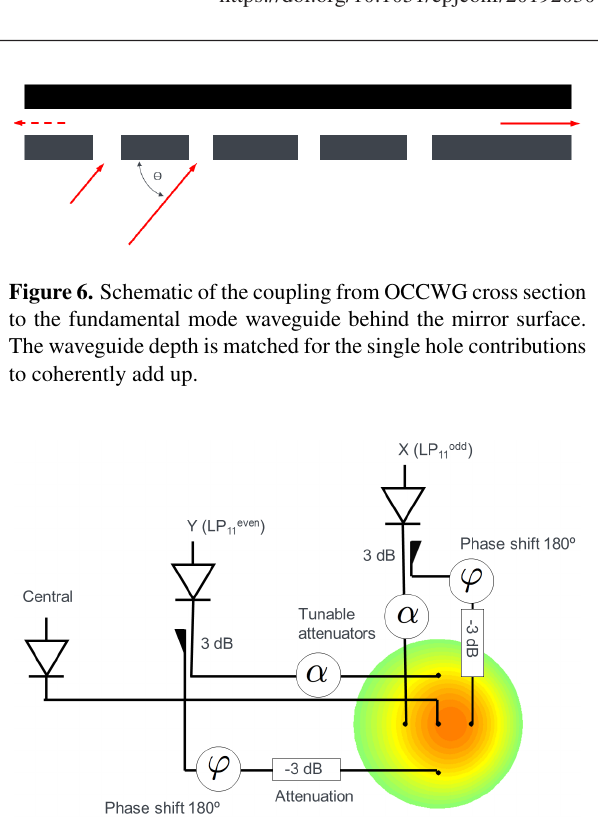
Figure 7. Schematic of an interferometric setup to measure di- rect error signals corresponding to the LP 11 modes from coupled channels.